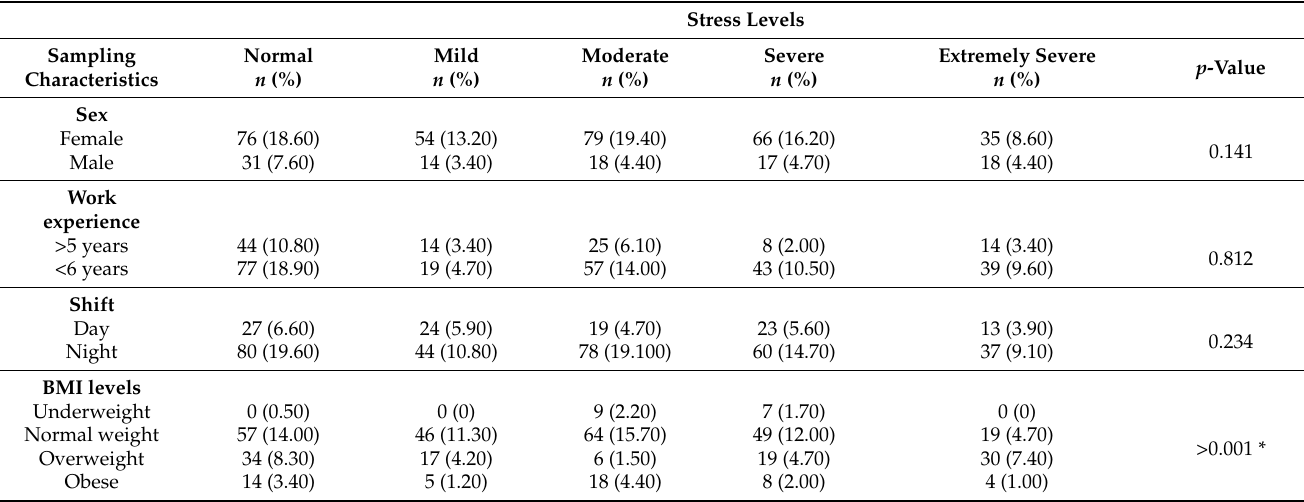
Table 3. Sampling characteristics according to stress levels.